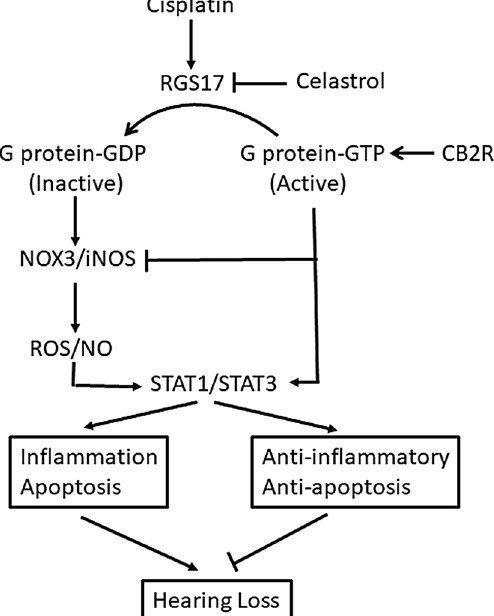
Figure 9. Proposed mechanism underlying the involvement of RGS17 in cisplatin ototoxicity. In the cochlea, cisplatin-induced increase in RGS17 negatively modulates otoprotective GPCR/Gα signaling by facilitating the inactive Gα-GDP state. This, we believe relieves a tonic suppression of ROS and reactive nitrogen species (RNS) generation via NOX3 and iNOS, respectively, increases cellular STAT1/STAT3 ratios and increases pro- inflammatory and apoptotic pathways. We believe these changes promote hearing loss. Inhibition of RGS17 (by celastrol, knockdown of RGS17 ) or activation of CB2 relieves the oxidative stress, reduced the STAT1/STAT3 ratios and inhibits cochlear inflammation and